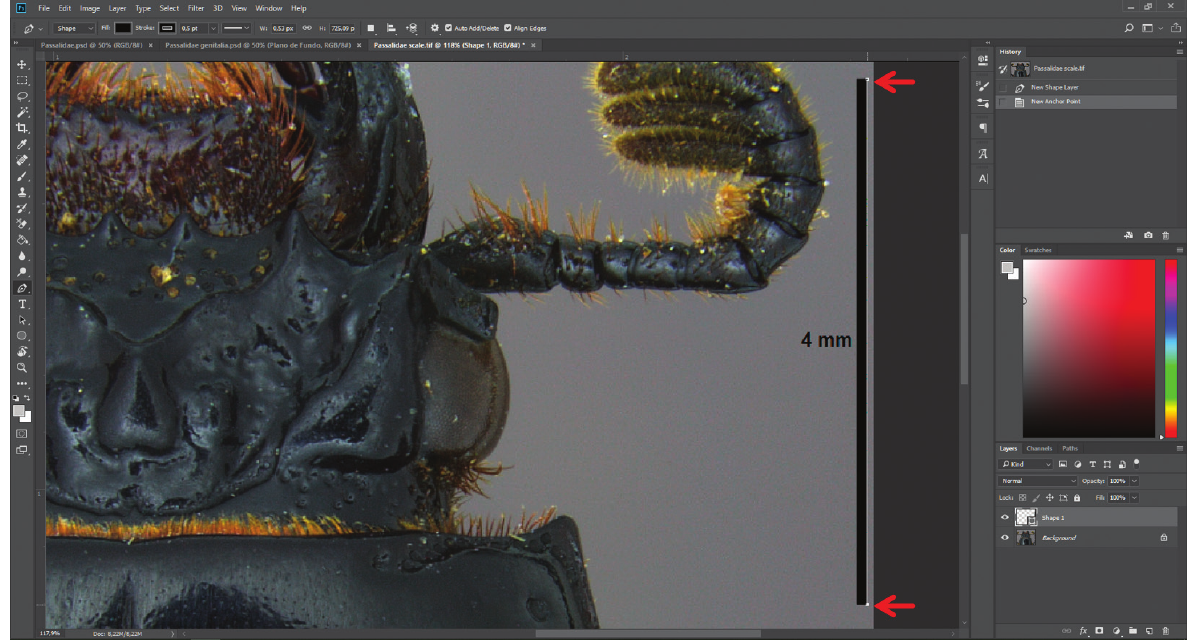
Figure 23. Method for creating a new scale using pen tool. Highlight the beginning and end of the pen tool